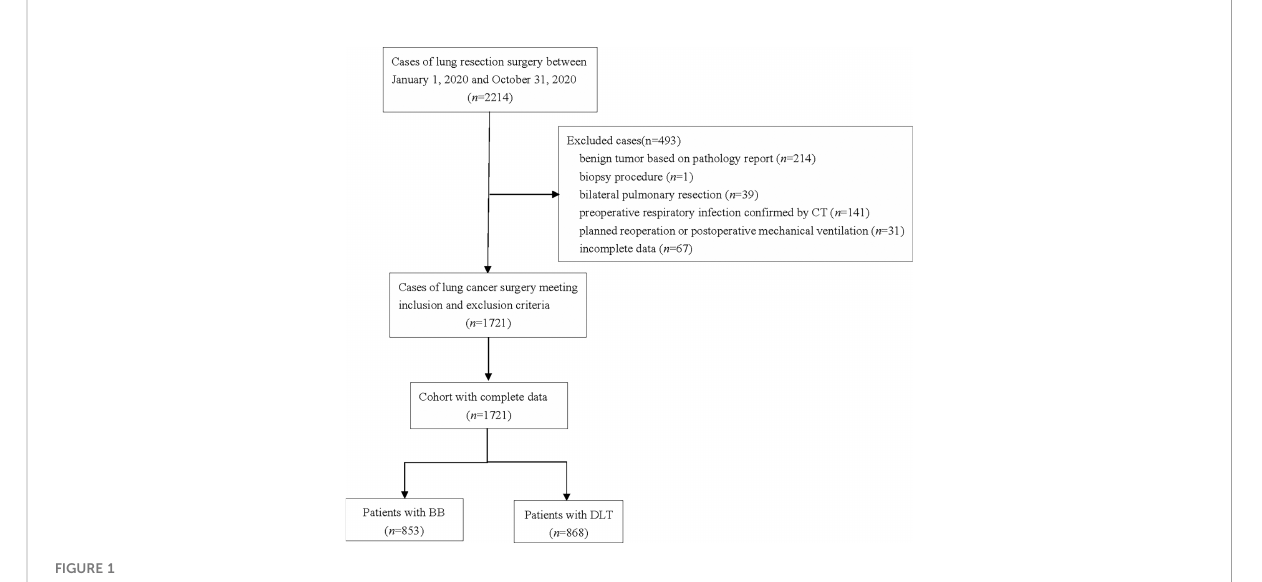
FIGURE 1 Flowchart of the